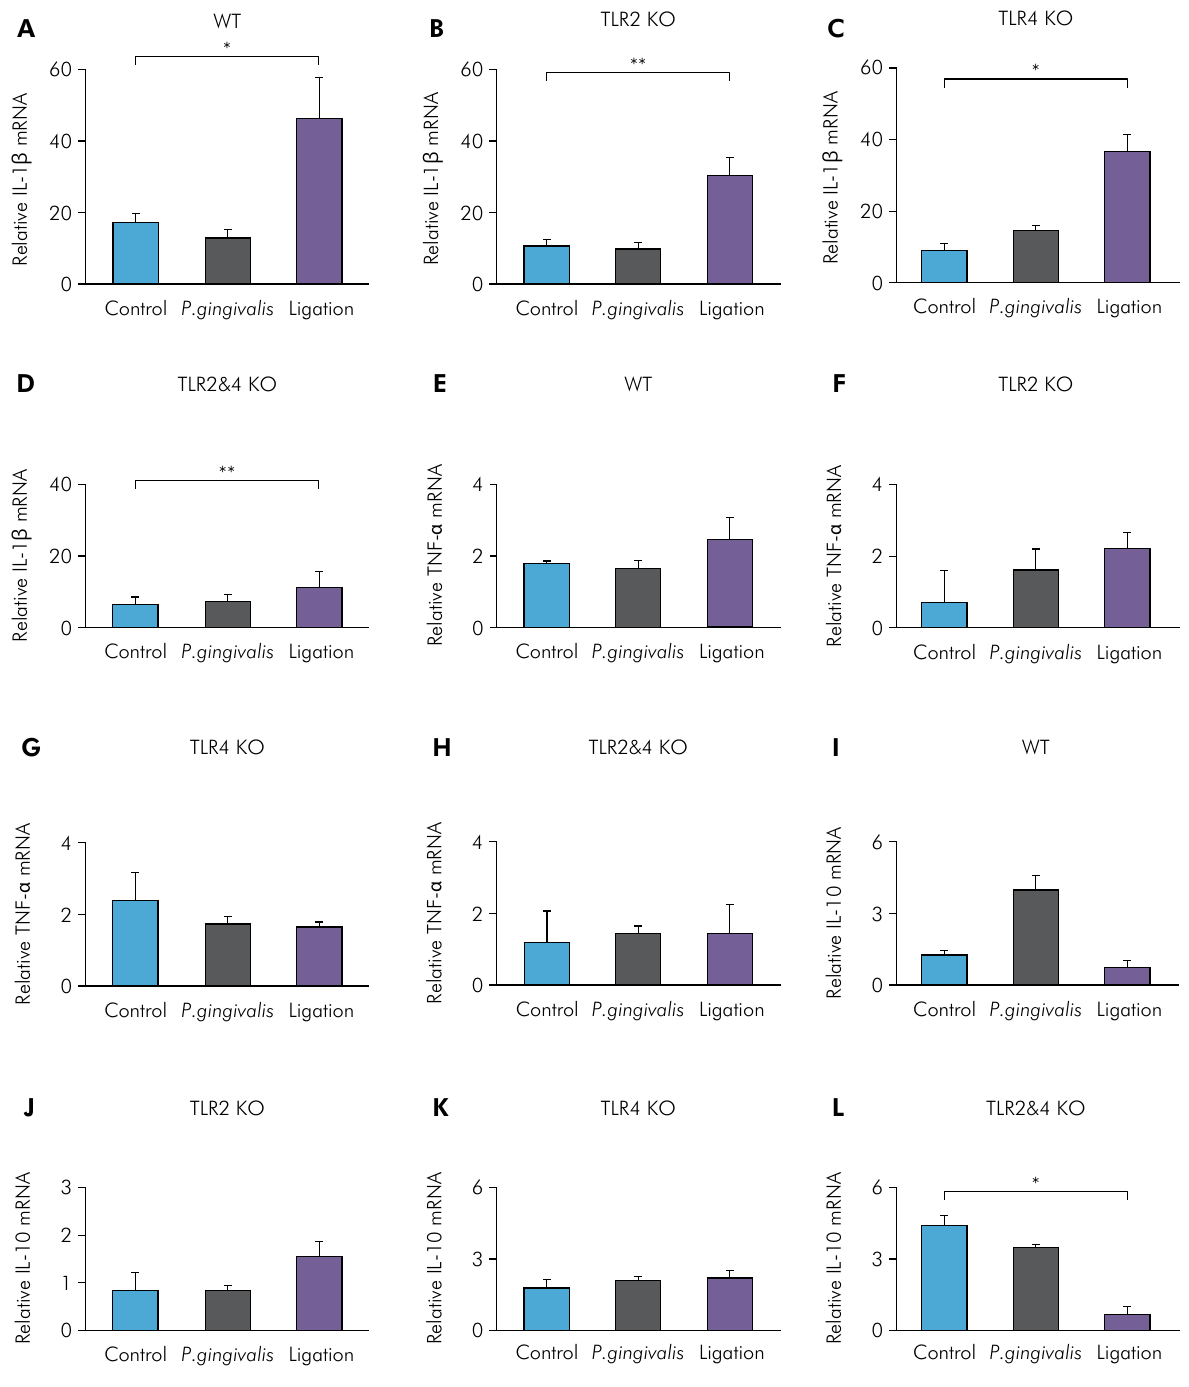
Figure 4. Gingival IL-1 β , TNF- α , and IL-10 mRNA levels of P. gingivalis -induced and ligation-induced experimental periodontitis in WT, TLR2 KO, TLR4 KO, and TLR2&4 KO mice. Gingival IL-1 β mRNA levels were determined by real-time PCR in the control group, the P. gingivalis infection group, and the ligation group of WT mice (A), TLR2 KO mice (B), TLR4 KO mice (C), and TLR2&4 KO mice (D) (means ± SE, n = 5 mice per group, *p < 0.05, **p < 0.01). Gingival TNF- α mRNA levels were determined by real-time PCR in the control group, the P. gingivalis infection group, and the ligation group of WT mice (E), TLR2 KO mice (F), TLR4 KO mice (G), and TLR2&4 KO mice (H) (means ± SE, n = 5 mice per group). Gingival IL-10 mRNA levels were determined by real-time PCR in the control group, the P. gingivalis infection group, and the ligation group of WT mice (I), TLR2 KO mice (J), TLR4 KO mice (K), and TLR2&4 KO mice (L) (means ± SE, n = 5 mice per group, *p < 0.05, **p <